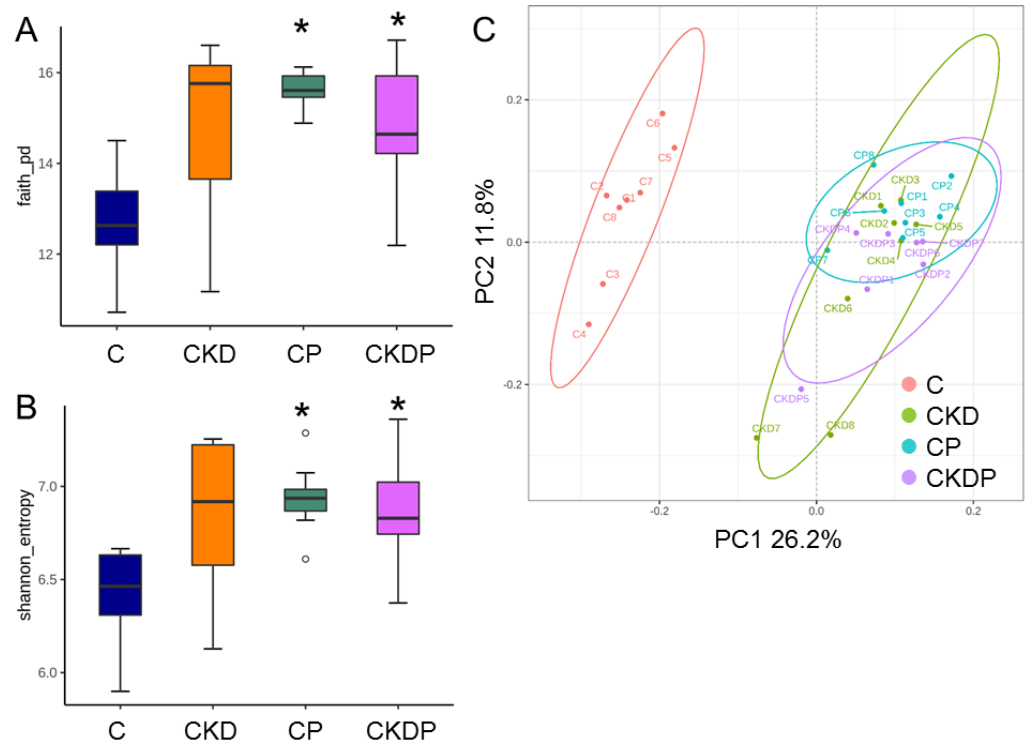
Figure 5. Comparison of bacterial α -diversity across four groups of offspring at the age of 12 weeks in ( A ) Faith’s phylogenetic diversity (PD) index and ( B ) Shannon index; ( C ) principal coordinate analysis (PCoA) based on unweighted UniFrac distance of the OTUs in four groups. Each point represents the microbiota of a single sample, and colors reflect metadata for that sample. * p < 0.05 vs. C.